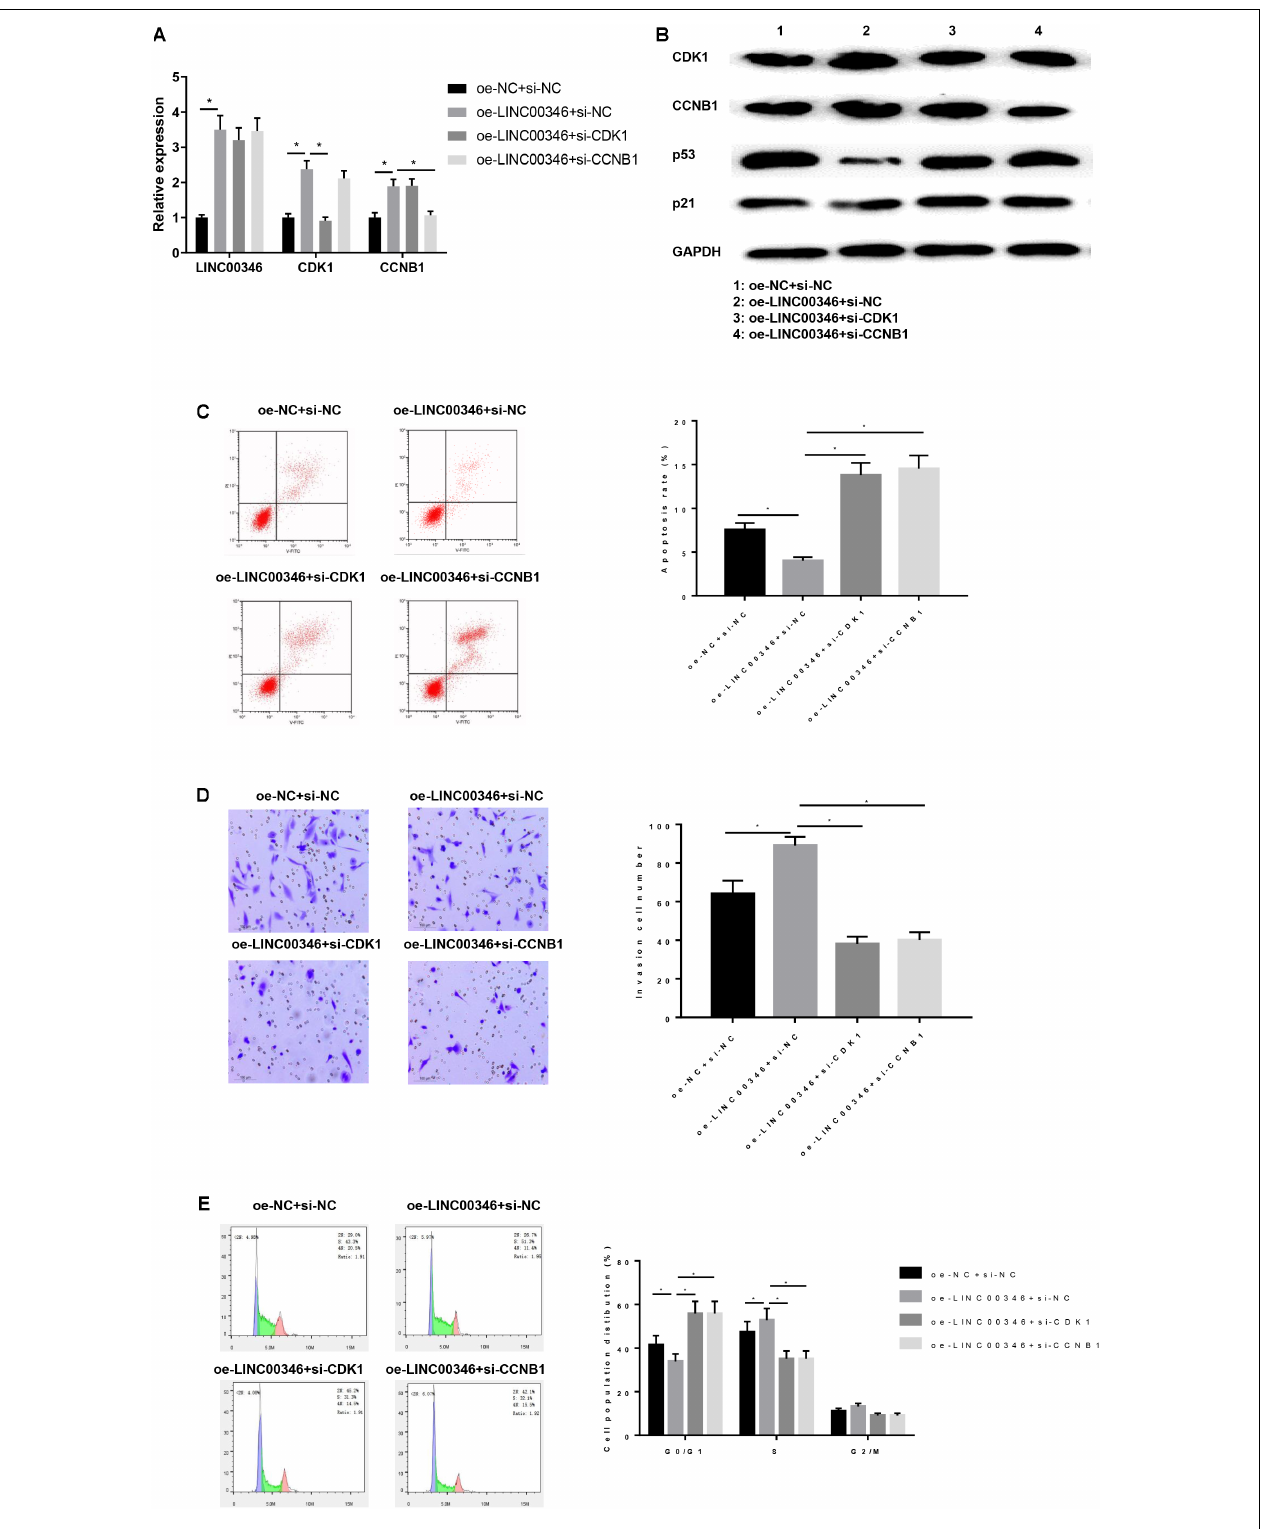
FIGURE 8 | LINC00346 affects the apoptosis, invasion and cell cycle of HCC by regulating the expression of CDK1 and CCNB1. The mRNA and protein expressions of LINC00346, CNK1, CCNB1, p53 and p21 in each group were detected by qRT-PCR and WB, respectively. Cells development in each group was detected by FCM and Transwell assays (100 × ). (A) The expressions of LINC00346, CDK1 and CCNB1; (B) Protein expressions of CDK1, CCNB1, p53 and p21; (C) Cell apoptosis; (D) Cell invasion; (E) Cell cycle. *represents P < 0.05.